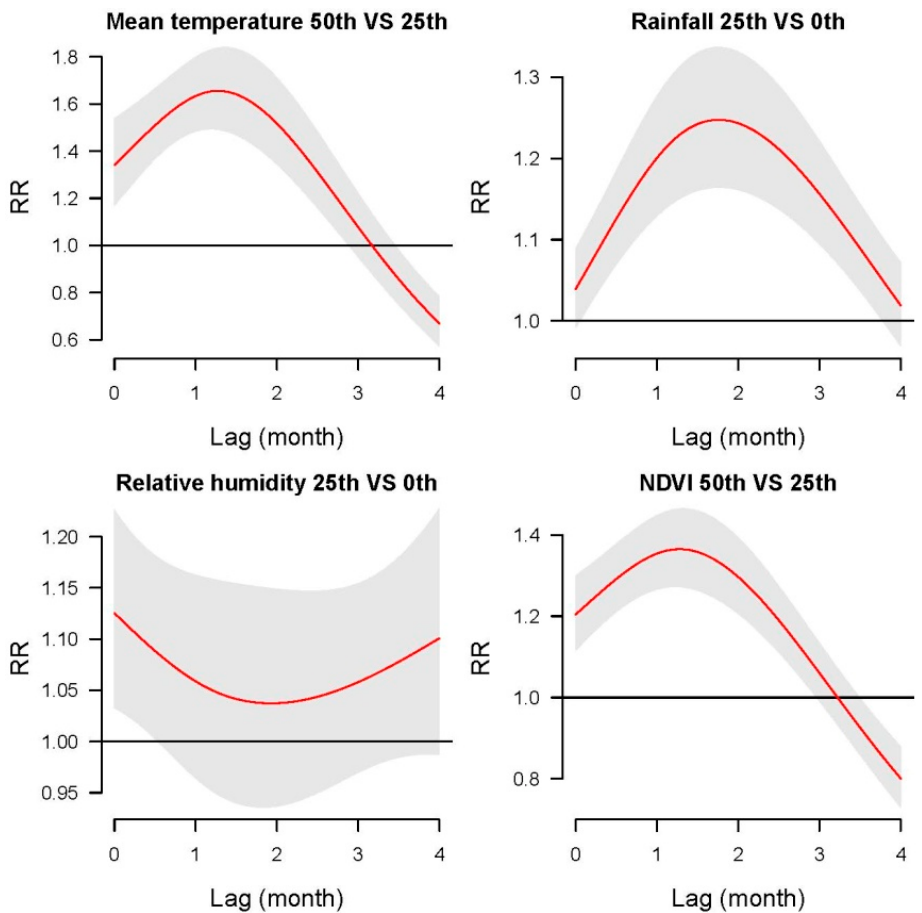
Figure 3. Pooled national level lagged impacts of mean temperature (50th percentile against 25th percentile), rainfall (25th percentile against 0th percentile), relative humidity (25th percentile against 0th percentile), and NDVI (50th percentile against 25th percentile) on HFRS infection from lag 1 to 4 months during 2002–2013.